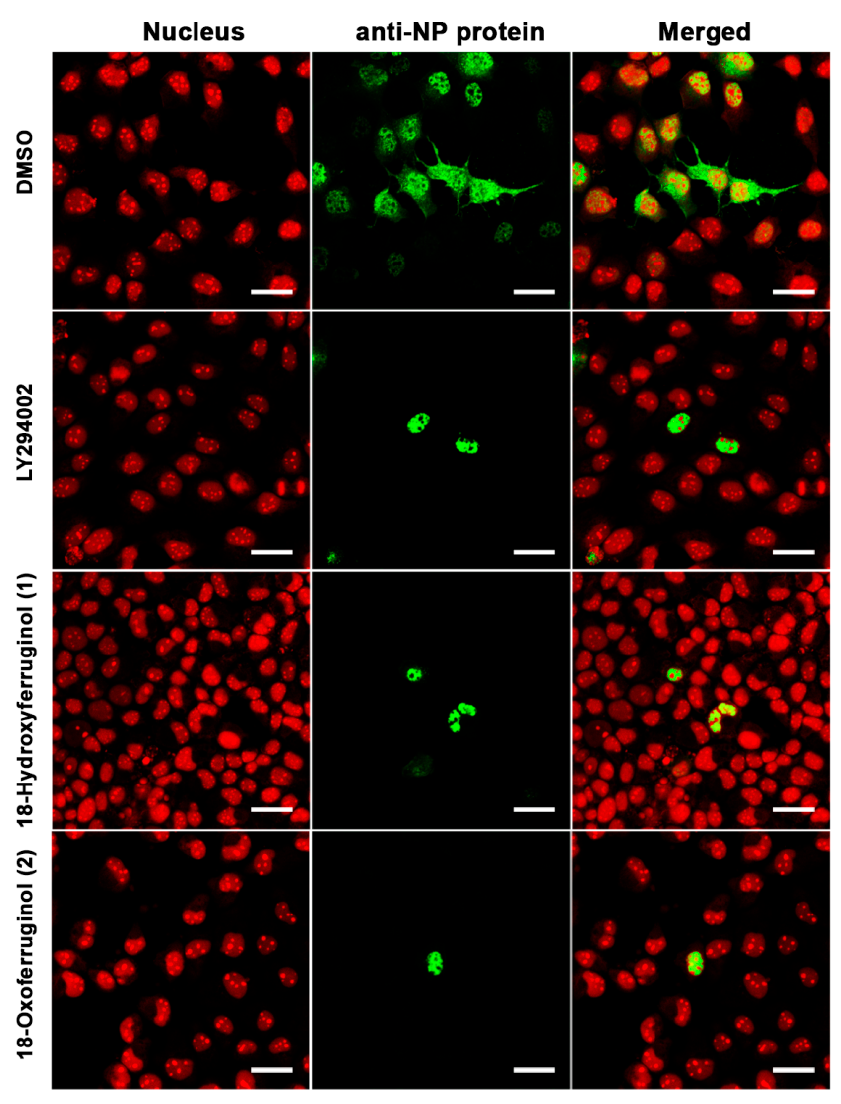
Figure 3. 18-Hydroxyferruginol ( 1 ) and 18-oxoferruginol ( 2 ) inhibit the export of the influenza virus RNP complex from the nucleus to the cytoplasm. MDCK cells were infected with H1N1 at 0.001 MOI in the presence of 0.5% DMSO, 50 µ M LY294002, 20 µ M 18-hydroxyferruginol ( 1 ), or 20 µ M 18-oxoferruginol ( 2 ). After 10 h, the cells were fixed in 4% paraformaldehyde. After blocking, the cells were incubated with the anti-NP antibody (green). Propidium iodide was used as a nuclear counterstain (red). Scale bar = 10 µ m.